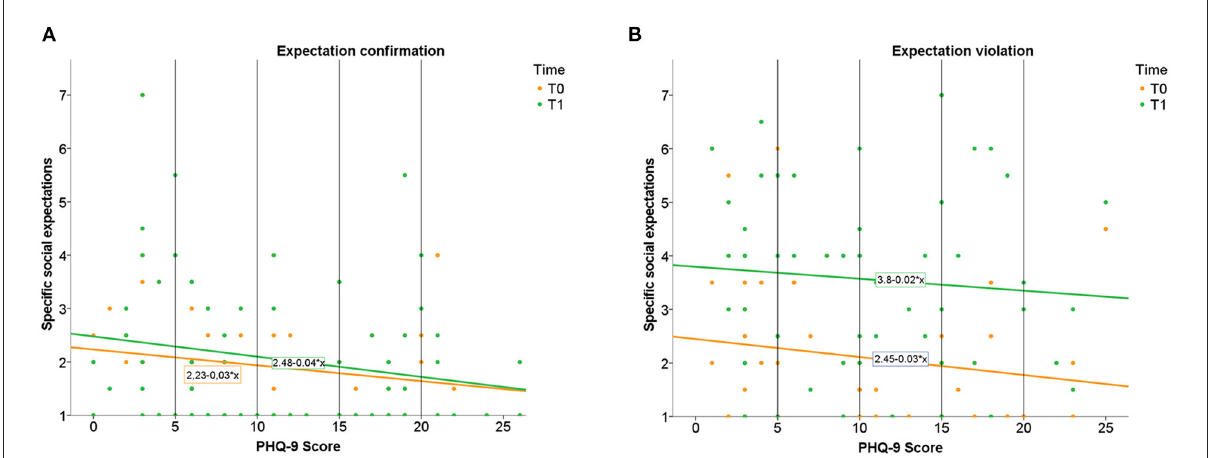
FIGURE3 Illustration of the results for specific expectation change. Specific expectations in relation to depressive symptoms (PHQ-9 Score) before and after expectation confirmation (A) and expectation violation (B) . PHQ-9 Score interpretation (vertical lines): 5 to 9 = mild severity, 10 to 14 = moderate severity, 15 to 19 = moderately severe, 20 to 27 = severe.